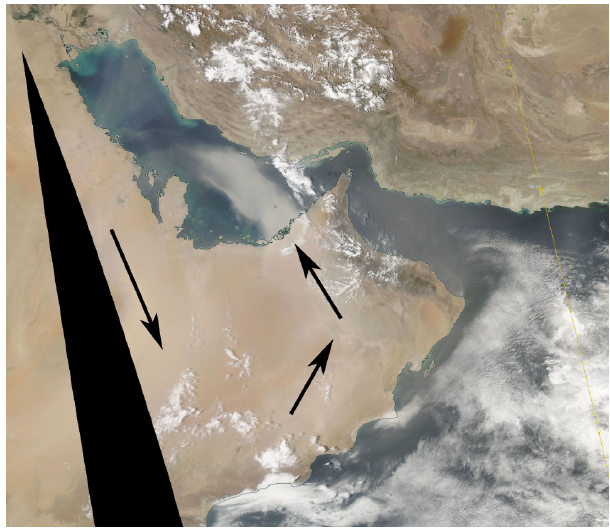
Figure 4. Snapshot of MODIS visible satellite image from 09:30UTC on 4 August 2016. Arrows indicate the main direction of lofted dust advection and